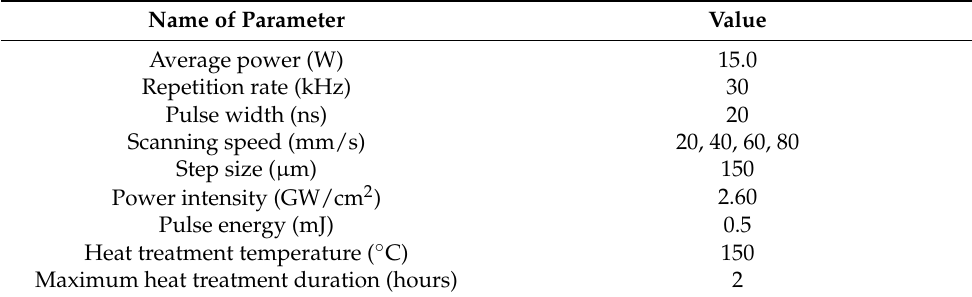
Figure 1. Pattern design used for laser surface structuring of BMG. Table 1. Processing parameters for the laser-based surface structuring experiments.